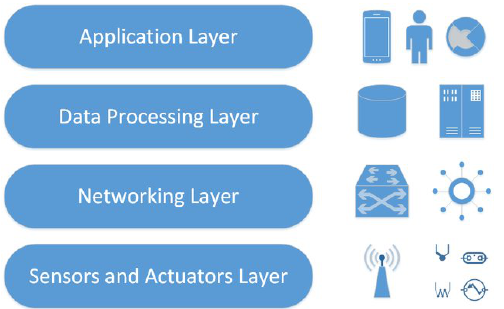
Figure 1. The generic architecture of IoT systems in a four-layered approach